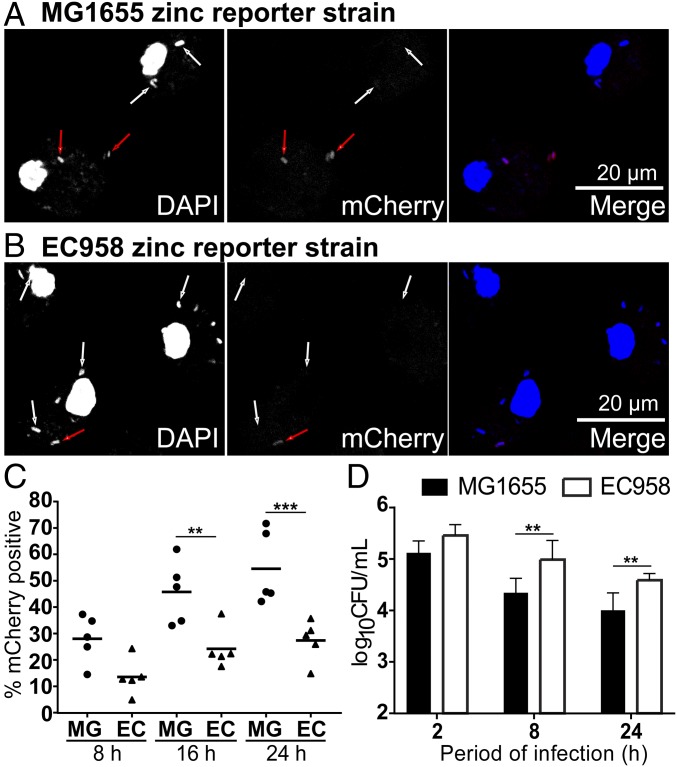
Analysis of zinc reporter strains demonstrates that EC958 evades the macrophage-mediated zinc stress response. (A–C) HMDM were infected with MG1655 pQF50-zntA-mCherry or EC958 pQF50-zntA-mCherry strains (MOI of 100) for 1 h, followed by gentamicin exclusion. At 8, 16, or 24 hpi, cells were fixed and stained with DAPI, then imaged for mCherry and DAPI fluorescence. Representative images at 16 hpi for MG1655 pQF50-zntA-mCherry and EC958 pQF50-zntA-mCherry are displayed in A and B, respectively (white arrows: mCherry− bacteria; red arrows: mCherry+ bacteria). Data are from a single experiment and are representative of five experiments. (C) The percentage of mCherry+ bacteria (as determined by DAPI fluorescence) was recorded for multiple images taken at each time point, and an average value for MG1655 (MG) and EC958 (EC) was determined at 8, 16, and 24 hpi. Data (n = 5) are combined from five experiments (performed in parallel for MG1655 and EC958). (D) HMDM were infected with MG1655 or EC958 for 1 h, then extracellular bacteria were removed by gentamicin exclusion. Cells were lysed at 2, 8, and 24 hpi and the CFU/mL determined. Data (mean + SEM, n = 5) are combined from five experiments. Data were log10-transformed and analyzed utilizing a two-way ANOVA, with Sidak’s multiple comparisons test. For C and D, **P < 0.01 and ***P < 0.001.